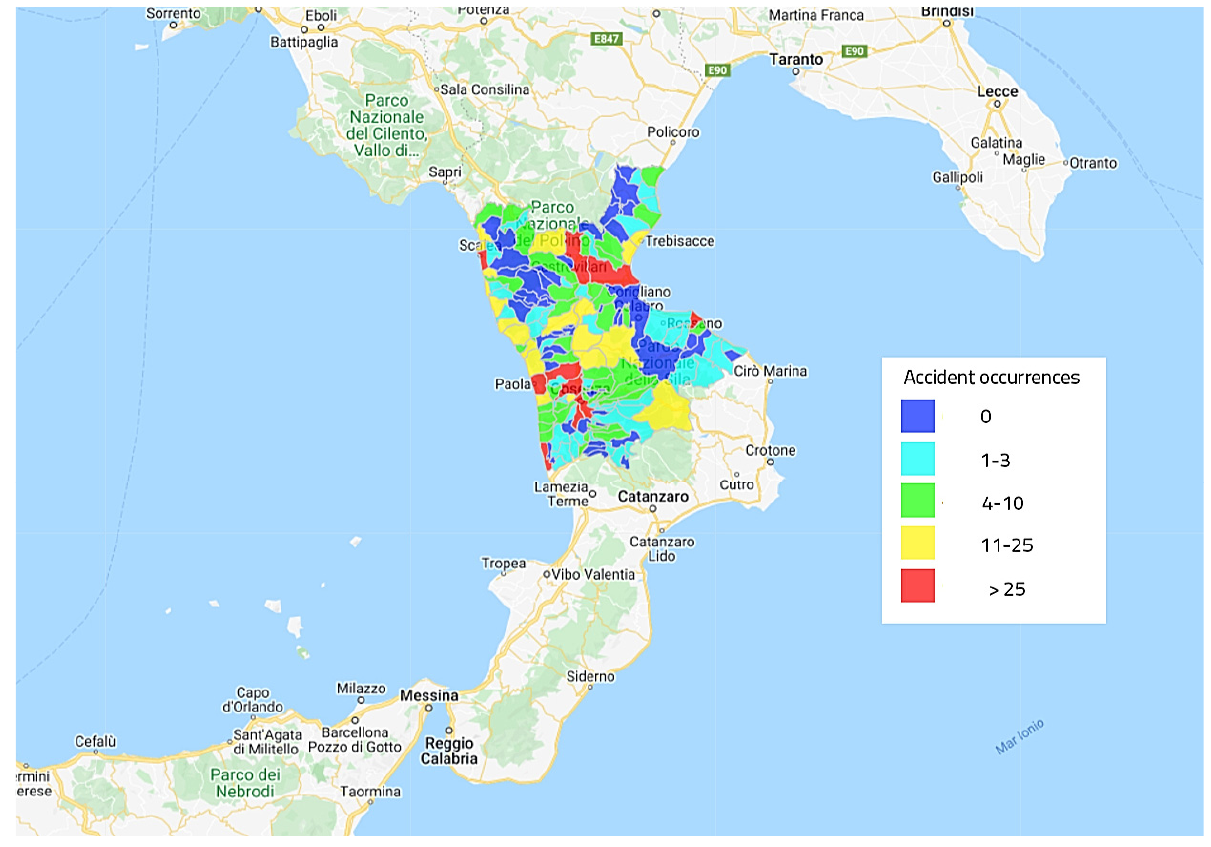
Figure 1. Rural roads accident map in the province of Cosenza (Italy) for the years 2017 and 2018 (source: Regional Center for the Collection of Data on Road Accidents in